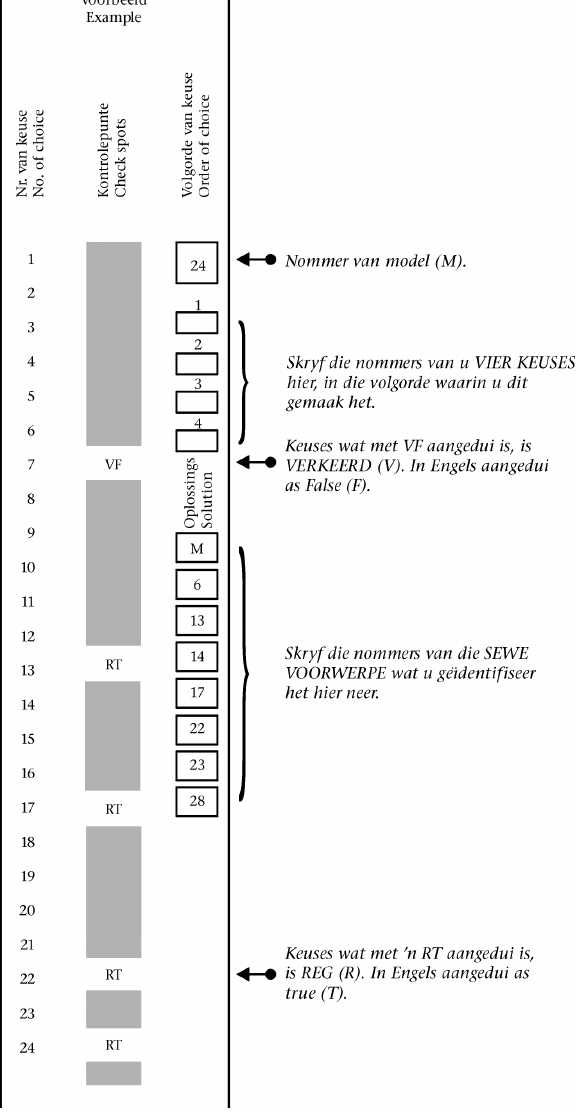
Figuur 2: Segment van